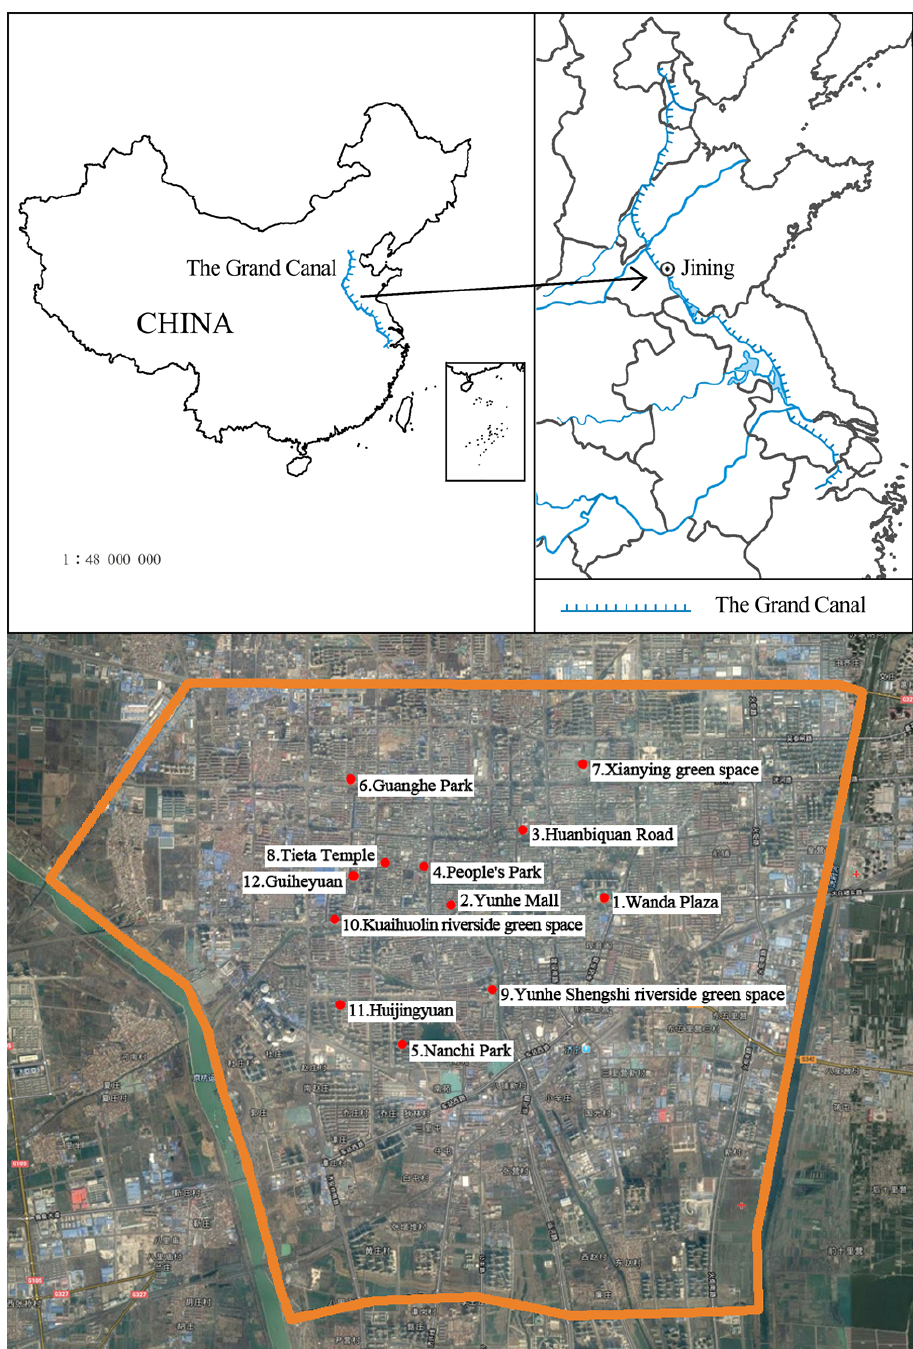
Figure 1. Study area and sample point distribution map for Jining urban space perception survey.